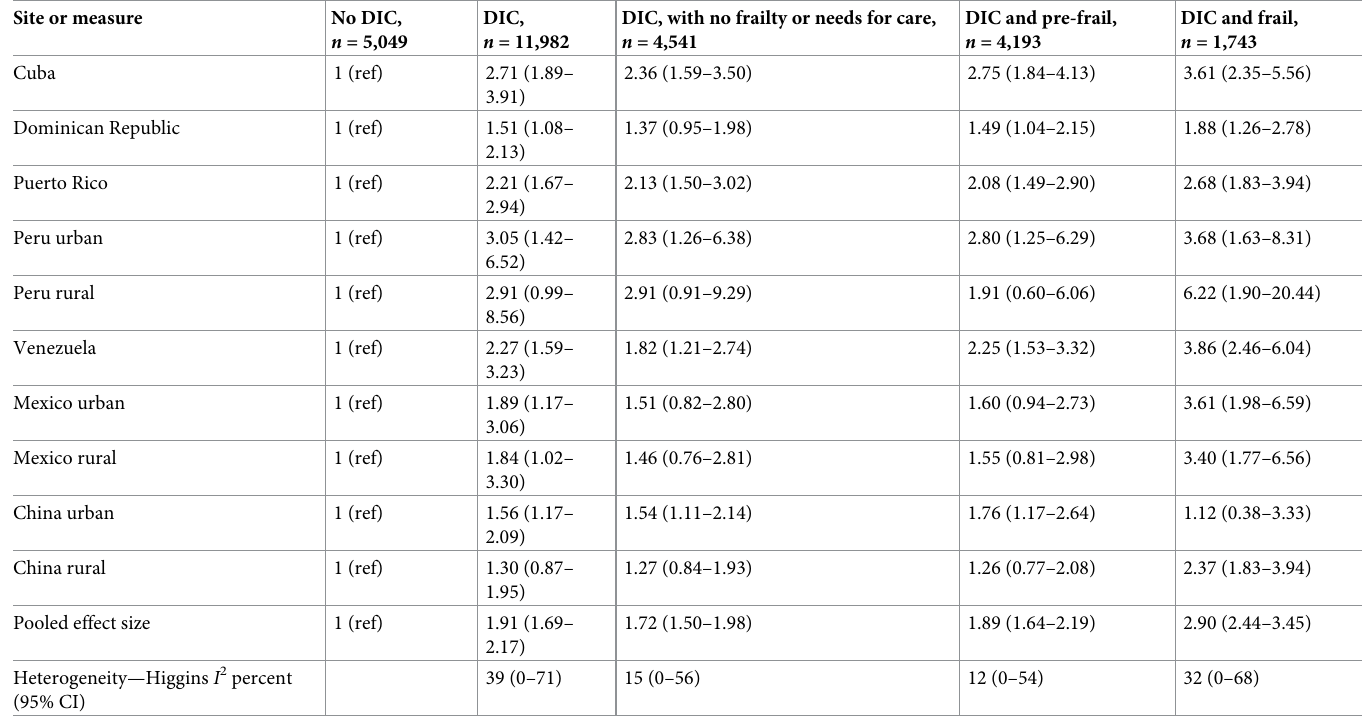
From a competing risks Cox proportional hazards regression, controlling for age, gender, and education, generating adjusted subhazard ratios and their 95% confidence